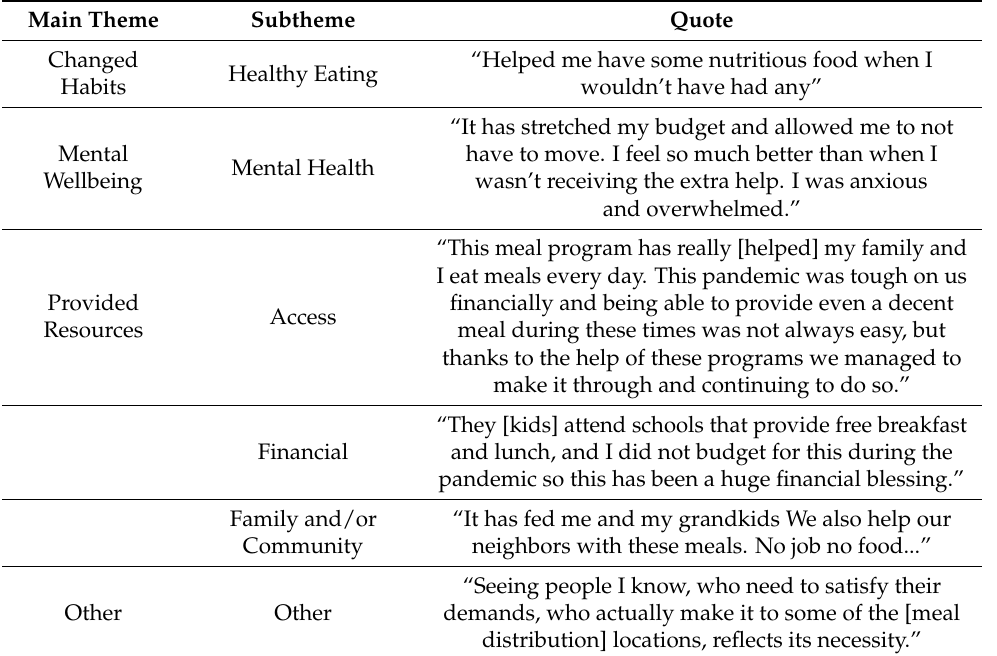
Table 2. Meal Recipient Raw Data Quote Examples with Main and Sub Themes .